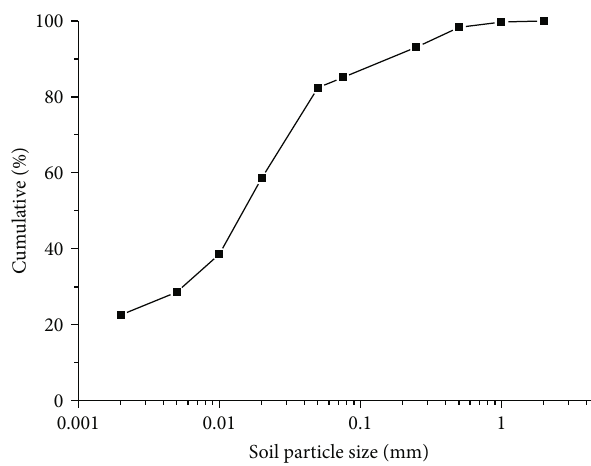
Figure 1: Particle gradation curve of the soil used in the